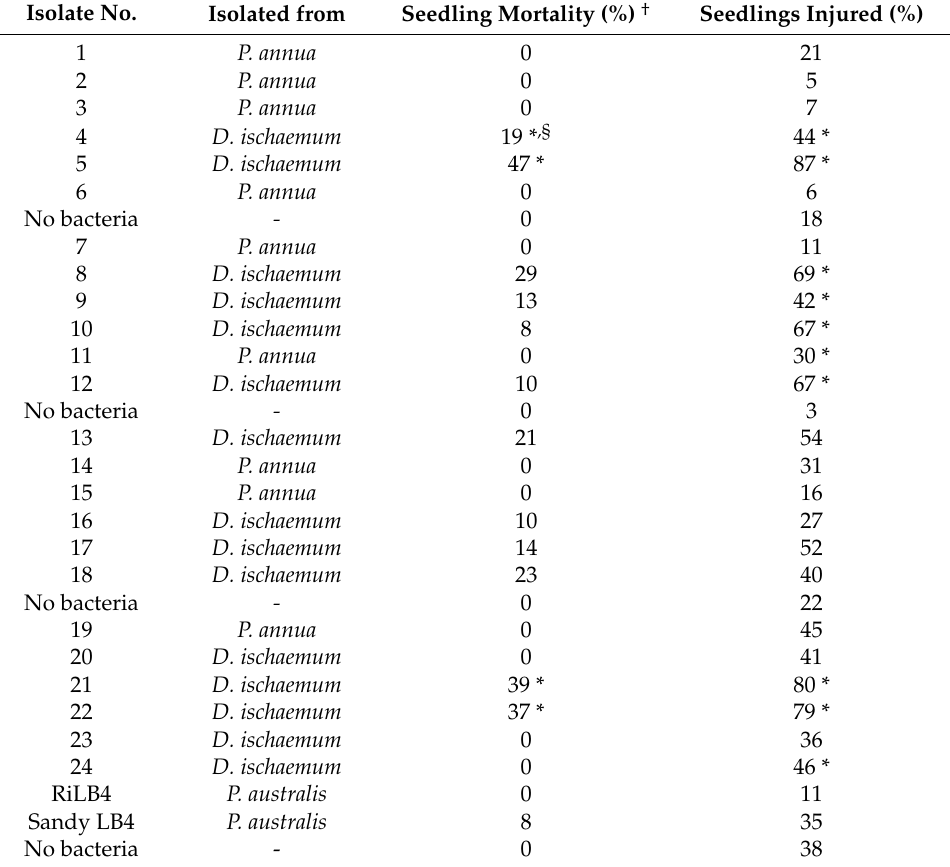
Table 1. E ff ect of bacteria collected outgrowing from surface-sterilized Digitaria ischaemum seeds and non-surface-sterilize Poa annua on Taraxacum o ffi cinale seedling mortality in axenic agarose